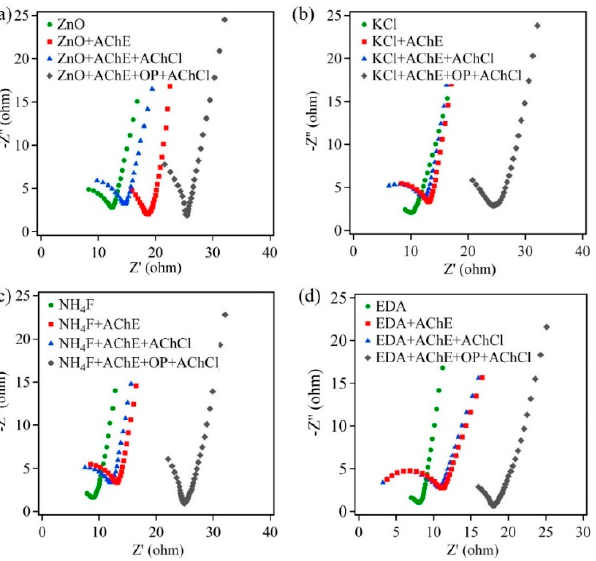
Figure 5. The Nyquist plot of ZnO samples on carbon paper: ( a ) ZnO, ( b ) ZnO + KCl, ( c ) ZnO + NH 4 F, and ( d ) ZnO +